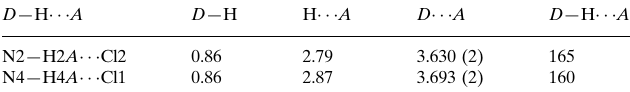
Hydrogen-bond geometry (A˚ , (cid:2)